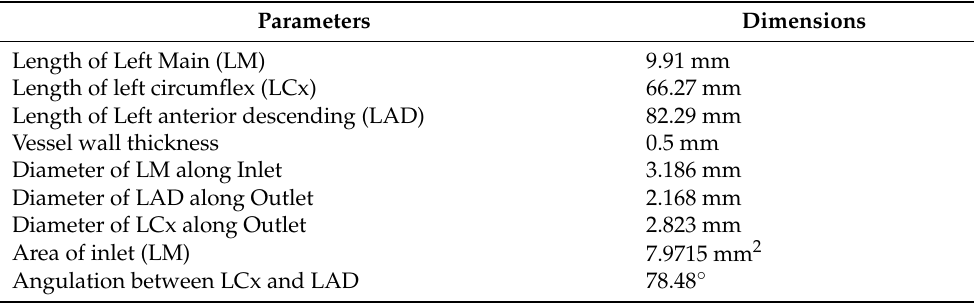
Figure 3. Geometrical details of Left anterior descending (LAD) and left circumflex (LCx) branches with cross-sectional (CS) planes at stenosis regions of Left Coronary artery (LCA). Table 2. Geometrical details of actual patient left coronary artery (LCA)